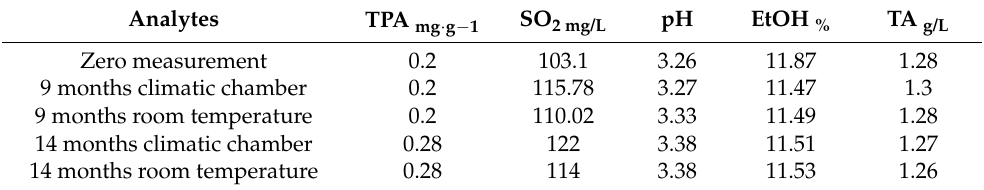
Table 8. Basic oenological parameters. Biologically active substances. P á lava. Basic oenological parameters . Sample C—P á lava, harvest 2016.